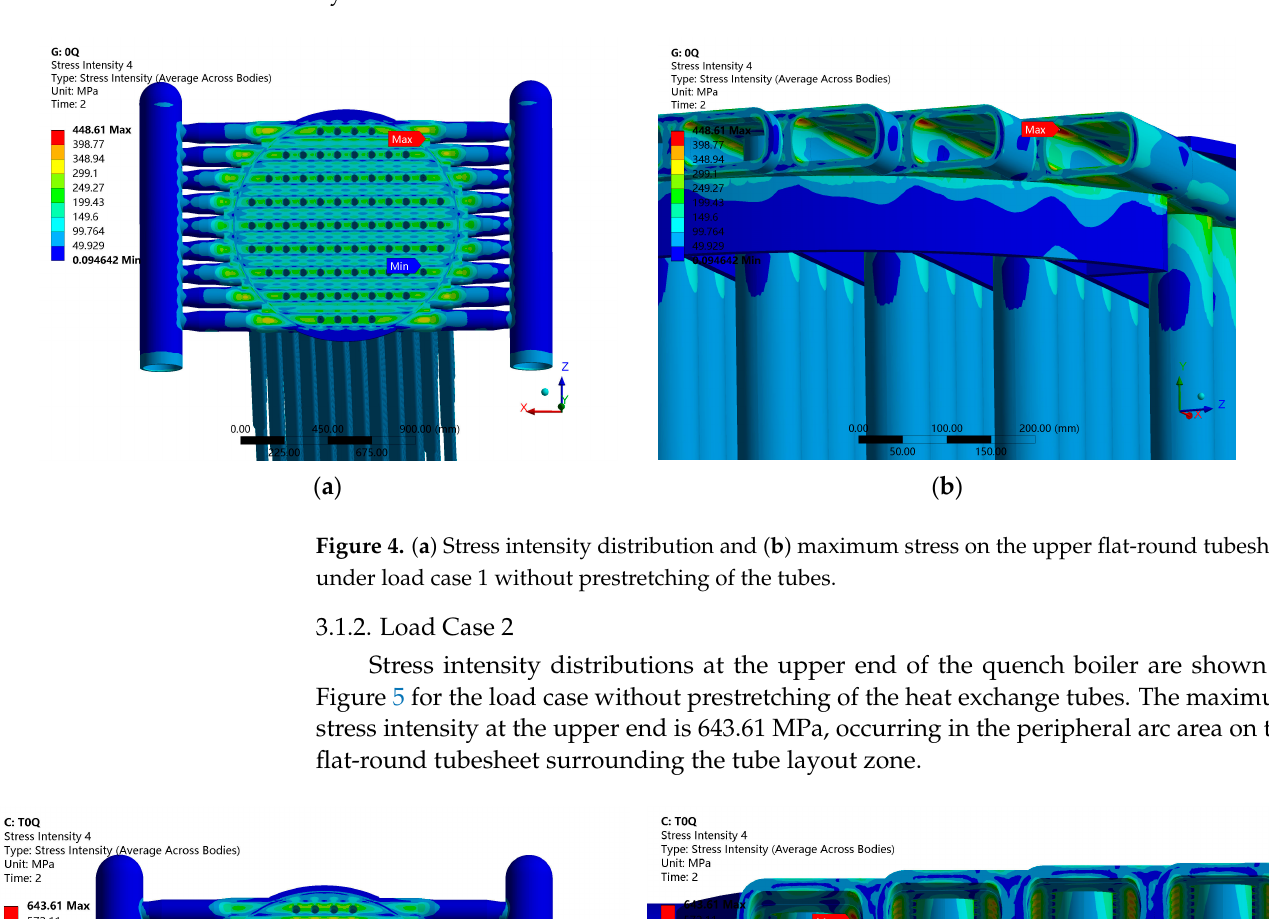
( b ) Figure 6. ( a ) Stress intensity distribution and ( b ) maximum stress on the upper flat-round tubesheet under load case 1 with 9 mm pretension of tubes. 3.2.2. Load Case 2 Stress intensity distributions at the upper end of the quench boiler are shown in Fig- ure 7 under the load case with prestretching of the heat exchange tubes. Compared with Figure 5, the stress on the flat-round tubesheet was considerable improved, with the max- imum stress intensity decreased to 418.44 MPa.